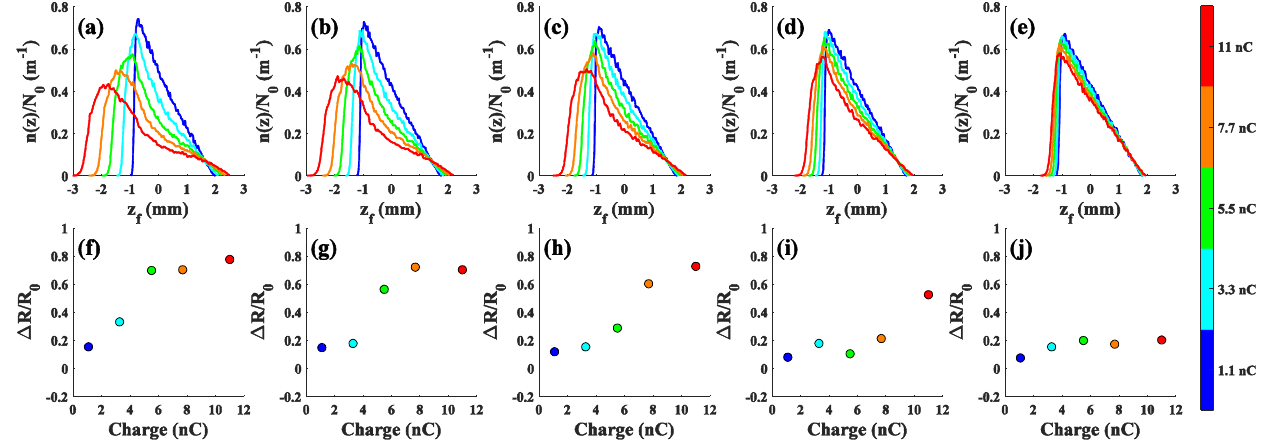
FIG. 10. The CSR effect. Longitudinal bunch shape at the end of EEX beam line with different charges after the mask (top), and corresponding transformer ratio drop (bottom). As we move from left to right (a) – (e), α 2 ¼ ð 20 0 ; 18 0 ; 16 0 ; 14 0 ; 12 0 Þ and L 2 . 00 m ; 2 . 31 m ; 2 . 68 m ; 3 . 16 m ; 3 . 79 m Þ . Corresponding ξ D 2 ¼ ð 2 for each case is (0.29 m, 0.27 m, 0.24 m, 0.21 m, 0.18 m). Note that the beam energy is 50 MeV to generate strong CSR but weak